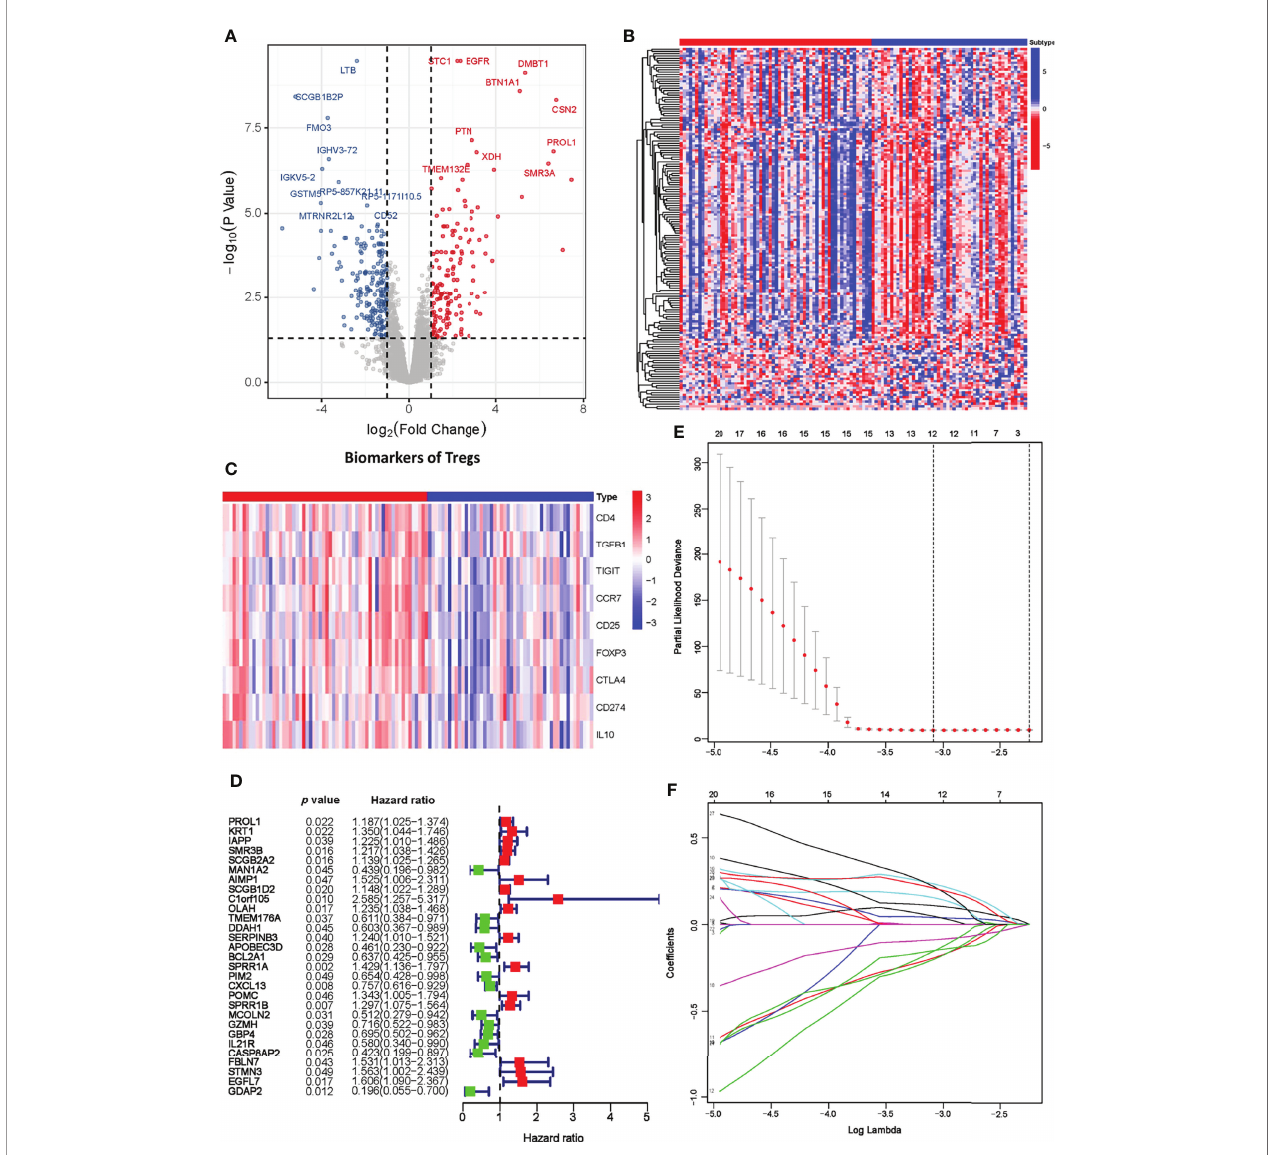
FIGURE 3 | Establishment of the Treg-related prognostic model. (A) Volcano plot of differentially expressed genes across the Treg-H and Treg-L groups. (B) Heatmap of immune-related gene expression in the Treg-H and Treg-L groups. (C) Heatmap of the expression levels of Treg biomarkers in the Treg-H and Treg- L groups. (D) Prognostic-associated DEGs identi fi ed by univariate Cox regression. (E, F) The prognostic signature constructed by LASSO